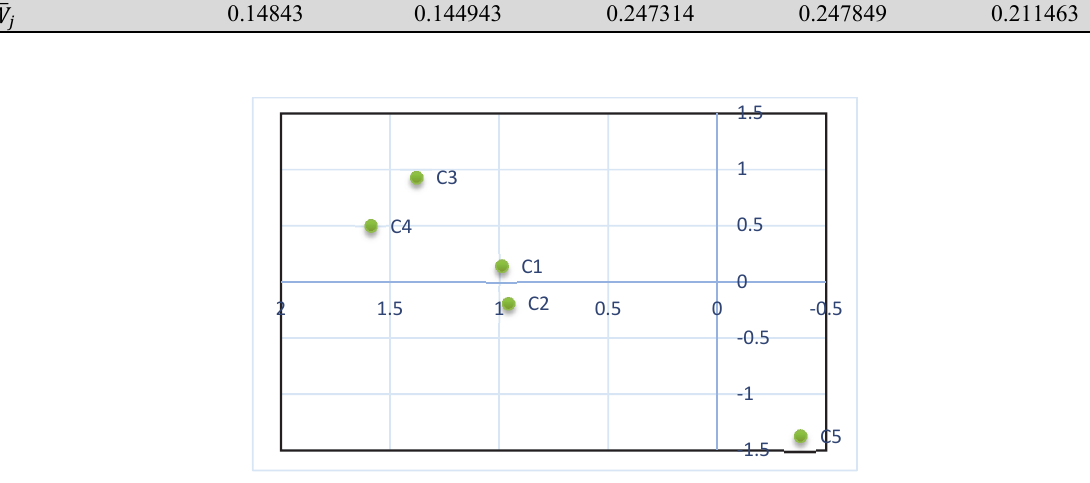
Relative weights of criteria Criteria